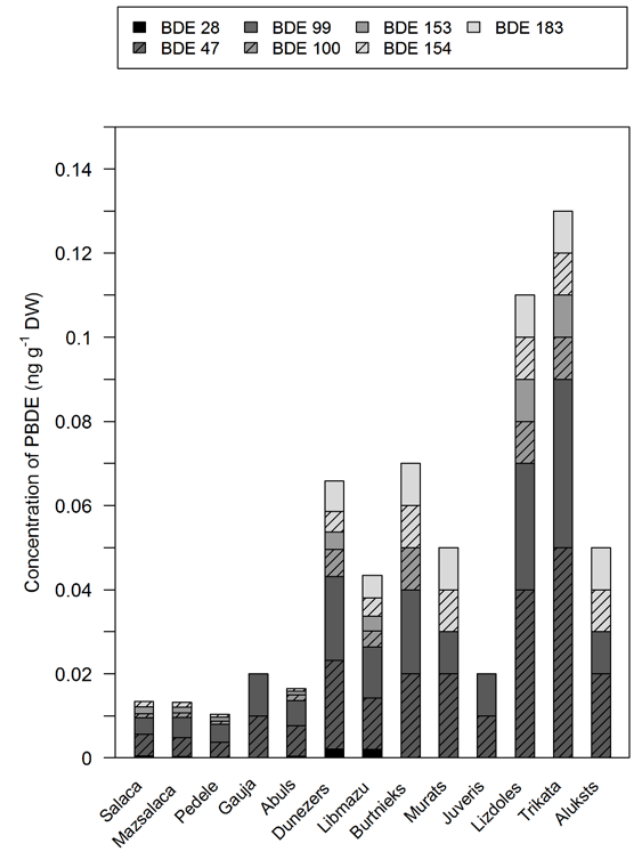
Figure 3. Concentrations of PBDEs in sediments from rivers and lakes in Latvia.